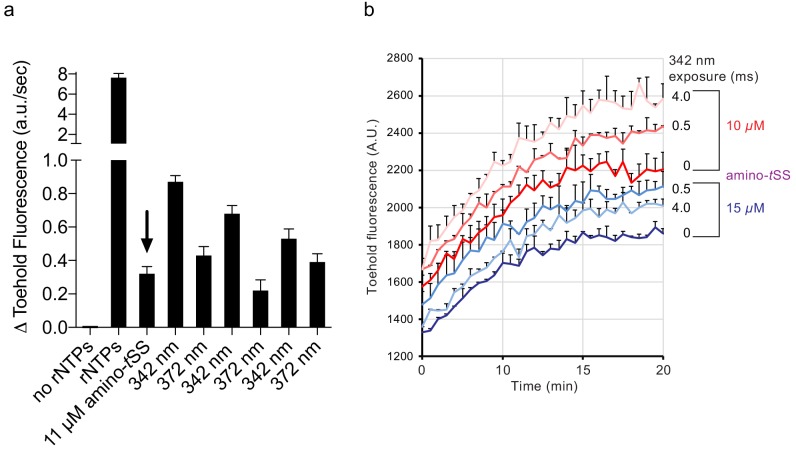
Co-transcriptional binding of a ribosome-mimic in vitro under amino-tSS photoisomerization conditions.(a) Initial transcription of Were-1 without ligand was induced by adding ribonucleoside triphosphates (rNTPs) to a transcription mix, producing robust toehold fluorescence increase (see Figure 2b for examples of co-transcriptional toehold binding). Upon adding 11 µM amino-tSS (arrow), fluorescence growth decreased, suggesting that Were-1 is bound to the ligand and prevents toehold binding. The sample was then exposed to 342 nm (Φq = 6.8*10−5 W/cm2) for 60 s (indicated by '342 nm' under the graph), causing photoisomerization of the ligand, and resulting in increased toehold fluorescence slope. Were-1 transcription reaction was subsequently exposed to 372 nm light (Φq = 1*10−4 W/cm2) for 60 s, to switch the ligand from cis to trans conformation, which resulted in decrease of toehold fluorescence slope. This was repeated two more times, as indicated, until the transcription reaction plateaued, and all toehold was expended. The data suggest that the system can be regulated multiple times in one reaction. Error bars represent fluorescence slope error. (b) Kinetics of co-transcriptional toehold fluorescence after irradiation with short pulses of 342 ± 10 nm light (Φq = 1.4*10−2 W/cm2) with exposure lengths indicated to the right of the graph. Experiments with 10 (red hues) and 15 µM (blue hues) amino-tSS are shown. Error bars indicate average deviation of two experiments.Figure 3—figure supplement 1—source data 1.Photoswitching of Were-1 binding by the DNA toehold.